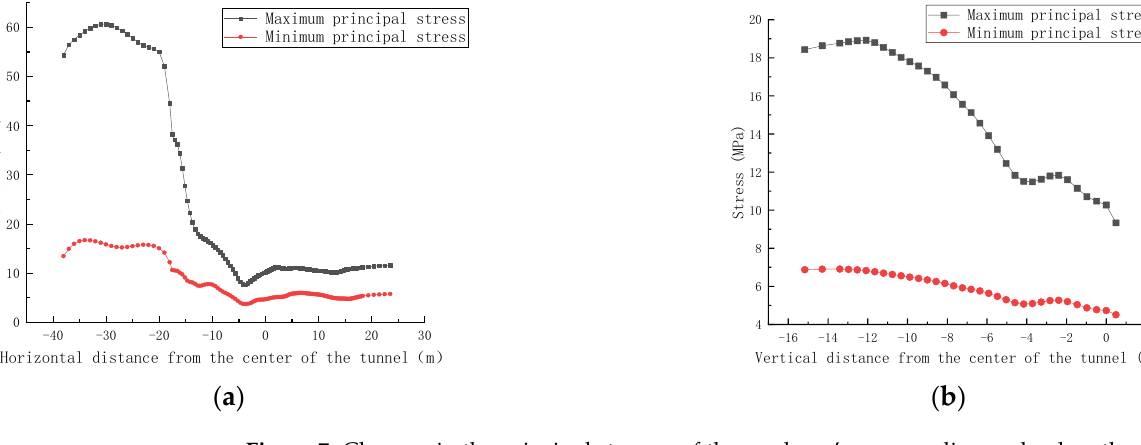
Figure 7. Changes in the principal stresses of the roadway’s surrounding rock when the roadway excavation along the roof. ( a ) Horizontal direction. ( b ) Variation